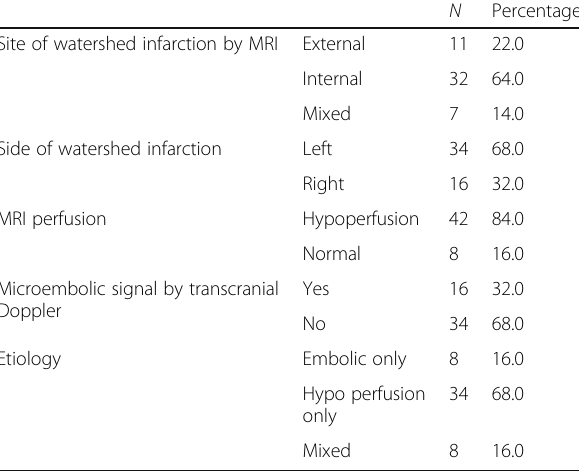
Table 2 Description of watershed infarction characteristics (site and side), MRI perfusion, and transcranial Doppler results among